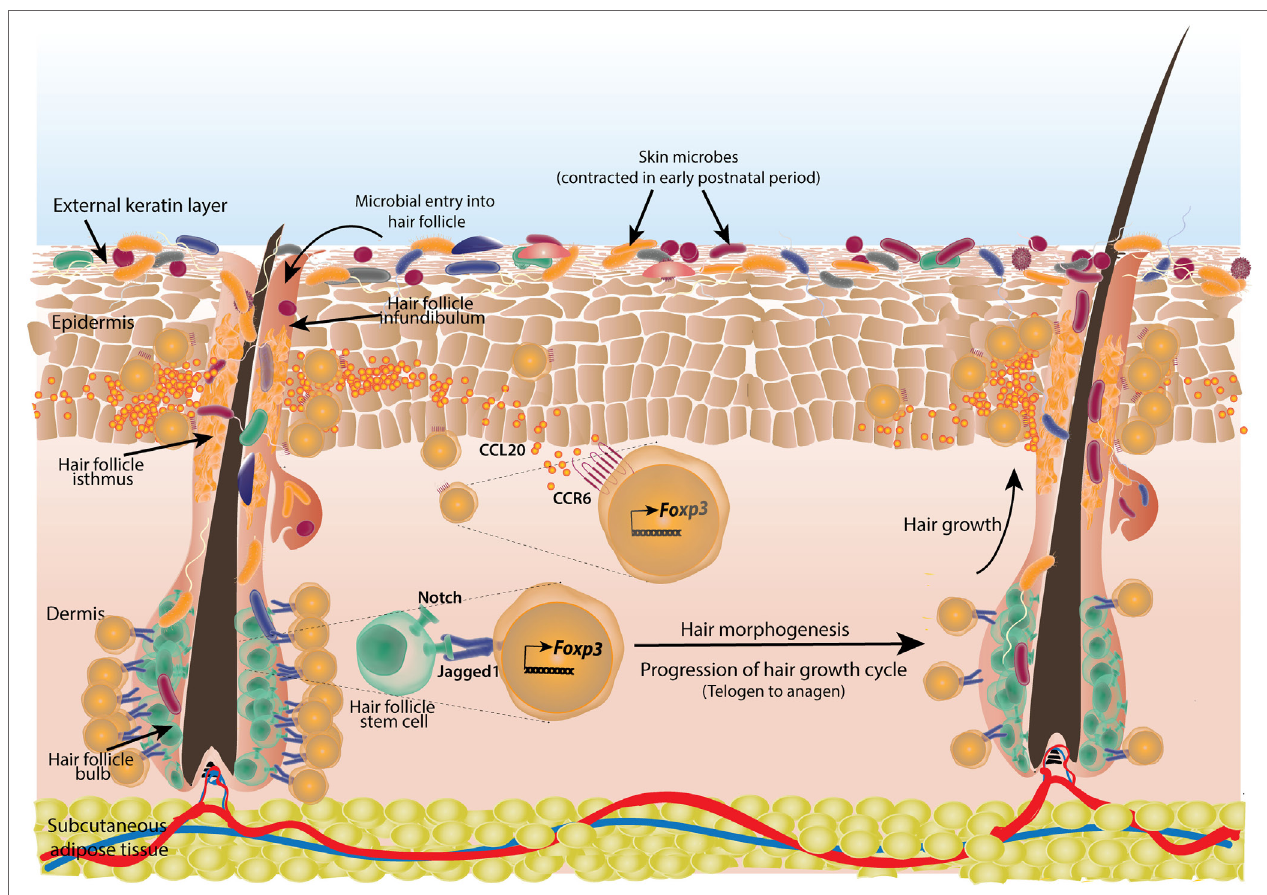
FiGURe 5 | Cutaneous regulatory T-cells (Tregs) facilitate hair morphogenesis and establish tolerance to skin commensals. Skin Tregs colonize mouse skin in early postnatal period coinciding with initial microbial colonization and hair follicle development. Skin microbes enter the hair follicle which induces production of chemokine CCL20 from infundibular cells that attracts large number of Tregs expressing corresponding receptor CCR6. The accumulated Tregs subsequently establish tolerance to these commensals. Also, during the resting phase of hair growth (telogen) which initially coincides with commensal entry in hair follicle, large number of Tregs are seen in contact with hair follicle stem cells (HFSCs) in the bulb of follicle. These Tregs provide notch ligand Jagged1 to the stem cells. Notch signaling triggers the active phase of hair growth cycle (anagen). Tregs are reduced in anagen phase around